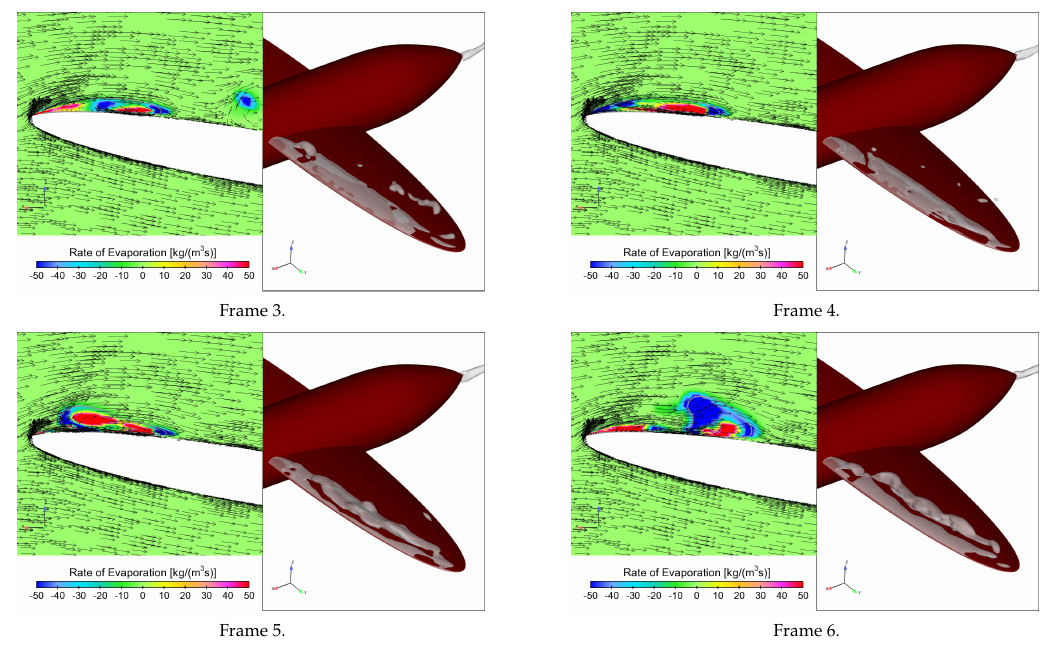
Figure 16. A sequence of snapshots visualizing one suction side sheet-cavitation shedding cycle. Fine grid, σ = 1.27, DDES. Left frame depicts a cut plane of the left foil at mid-span, with velocity vectors denoted by arrows (only 25% of the velocity vectors is drawn on the plane for clarity), contour of the void fraction α = 0.1 denoted by the grey curves, and the plane is colored by the rate of evaporation. The right frame shows the cavity extent near the left foil by an iso-surface of α = 0.1. The frame number denotes the respective stage of the